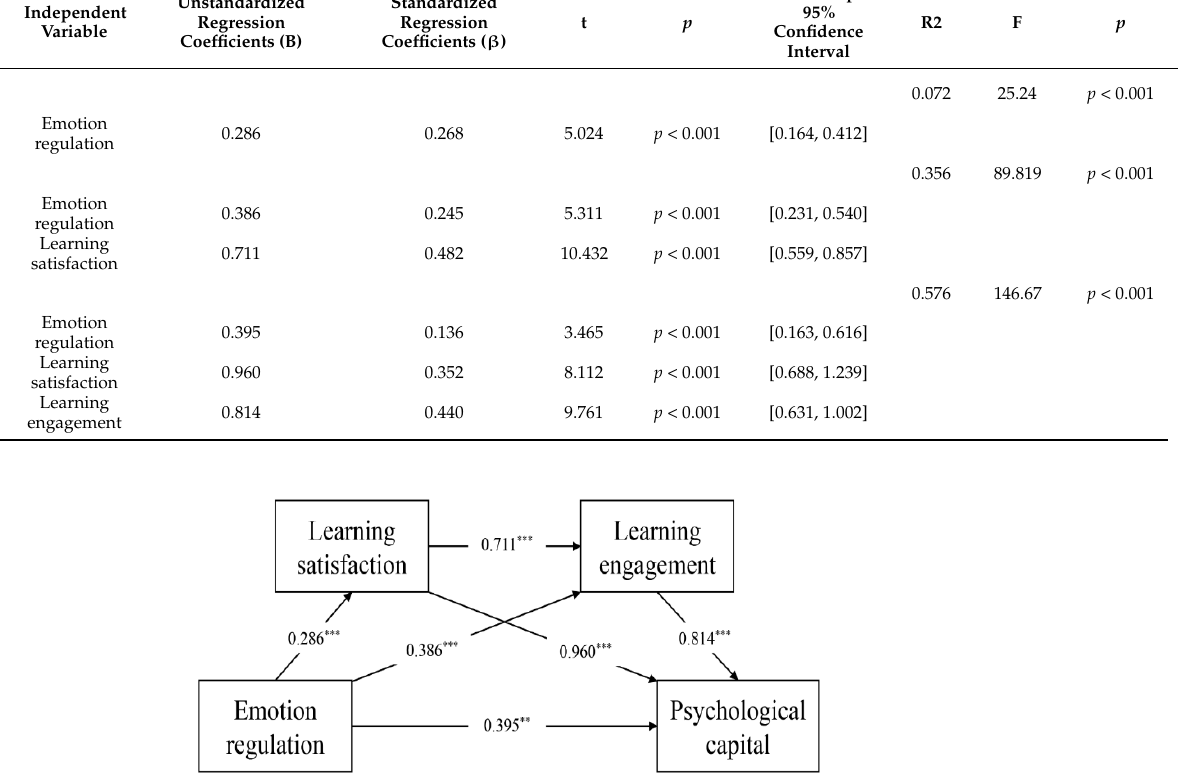
Figure 1. Mediation effect of learning satisfaction and learning engagement on the influence of emotion regulation on psychological capital. Note: ** p < 0.01, *** p < 0.001.